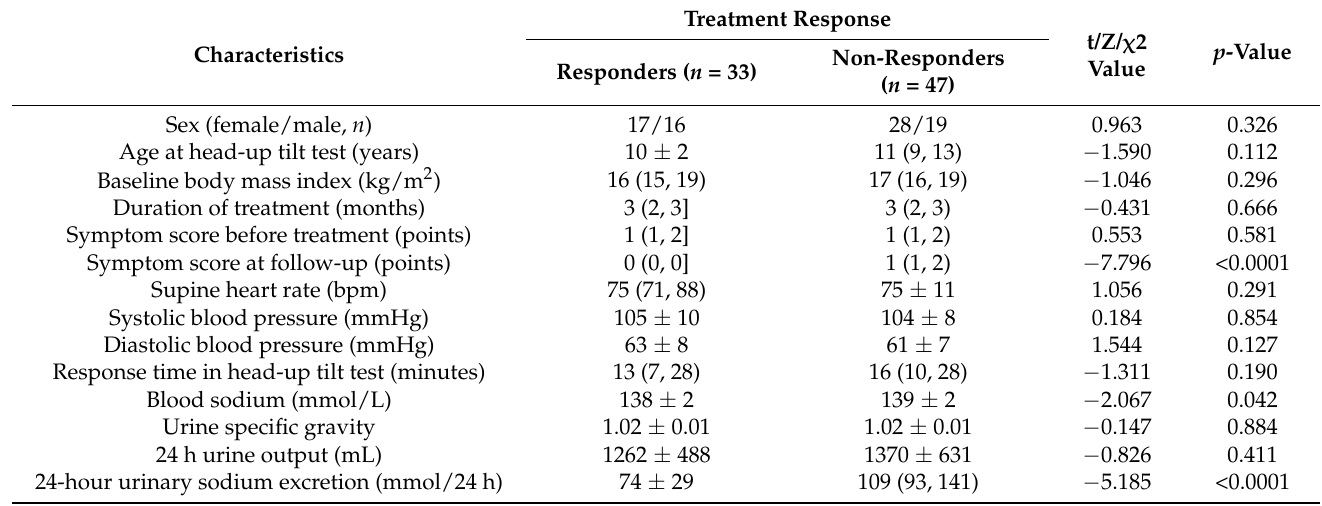
Table 1. Comparison of demographic, clinical and laboratory results between responders and